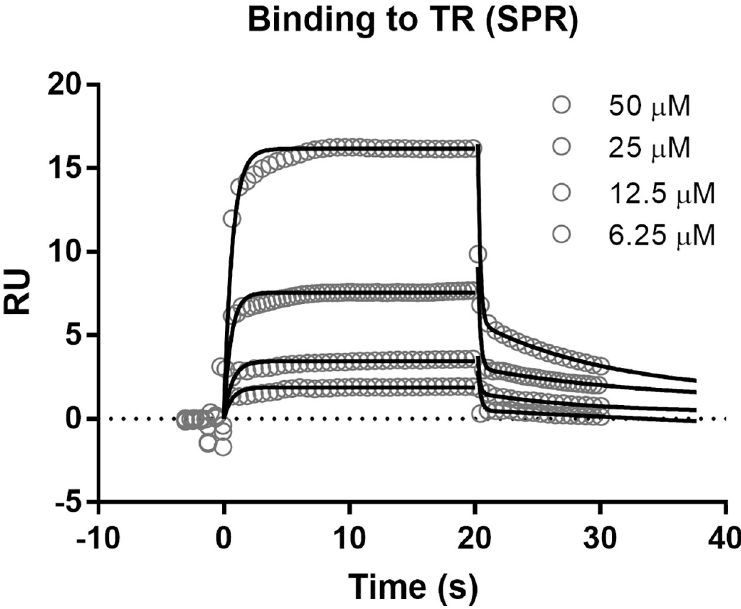
Fig 6. Compound 3 binding to TR as measured by SPR. Every other four experimental point is plotted to allow a cleaner representation. The plot is one representative experiment of four.